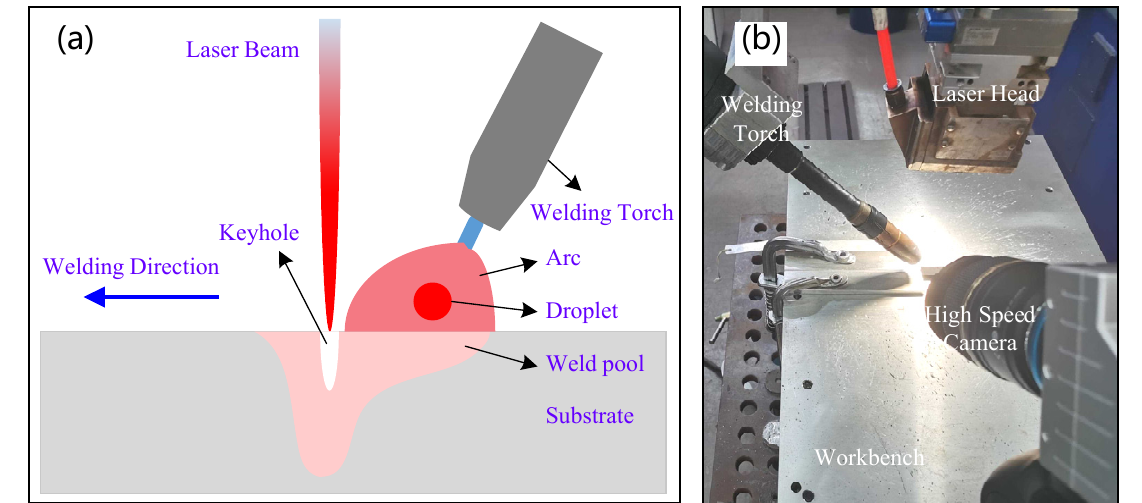
Figure 1. ( a ) Schematic diagram of hybrid laser arc welding; ( b ) Experimental setup.